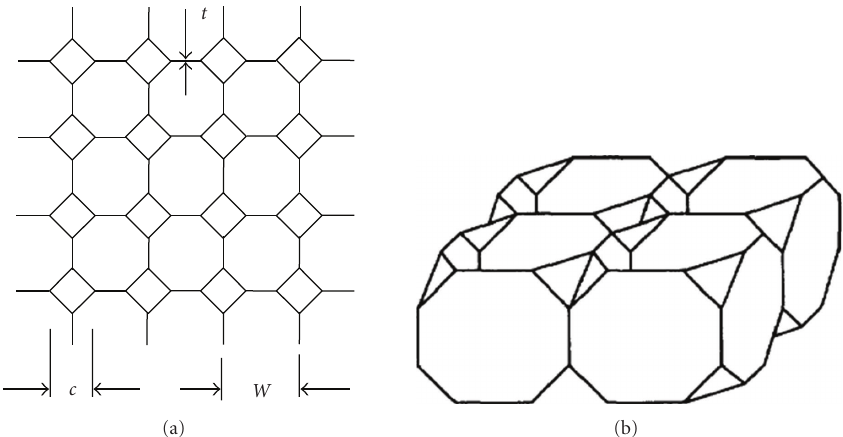
Figure 3: Schematic diagram of the truncated cube model (a) top view (cell morphology), and (b) isometric view (3-D structure) of the model.